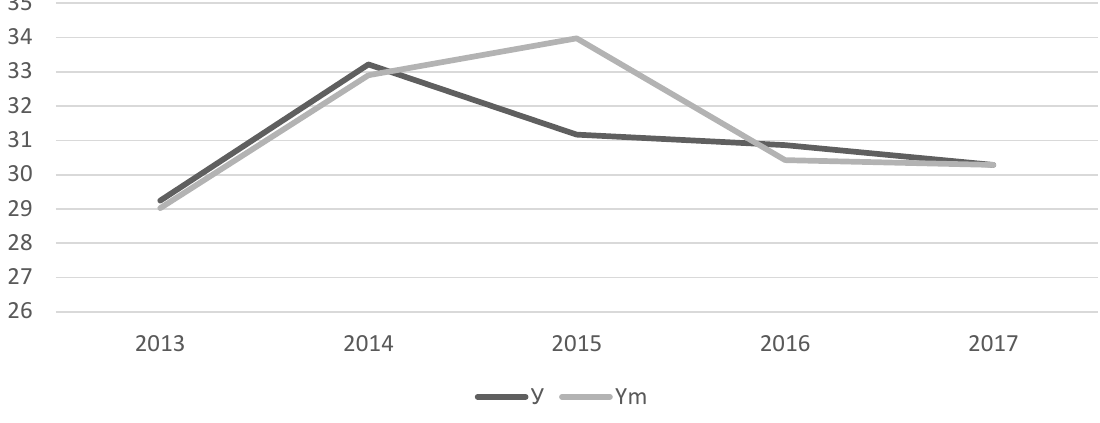
Figure 3. Graphic representation Y and Ym of the total financial security of the country